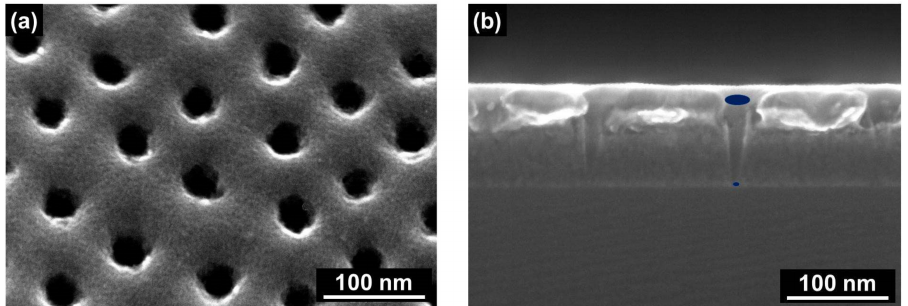
Figure 2. ( a ) A top view SEM image of the upper side of the SSM and ( b ) a cross-section SEM image